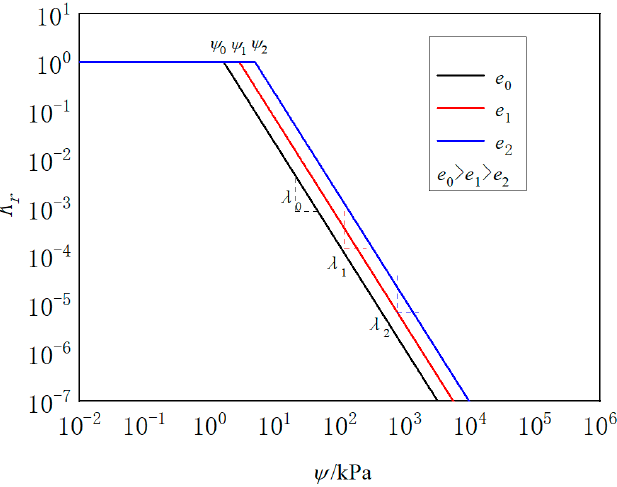
Figure 1. Law of permeability coefficient of unsaturated soil under deformation conditions.